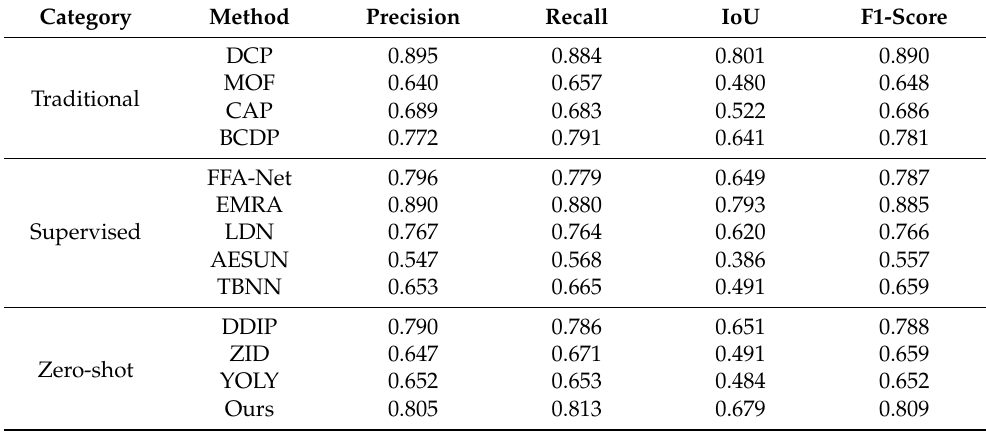
Table 6. Quantitative comparisons of D-LinkNet road extraction accuracy using the dehazed images of different dehazing methods. The best value of the specific metric for each category is in boldface.